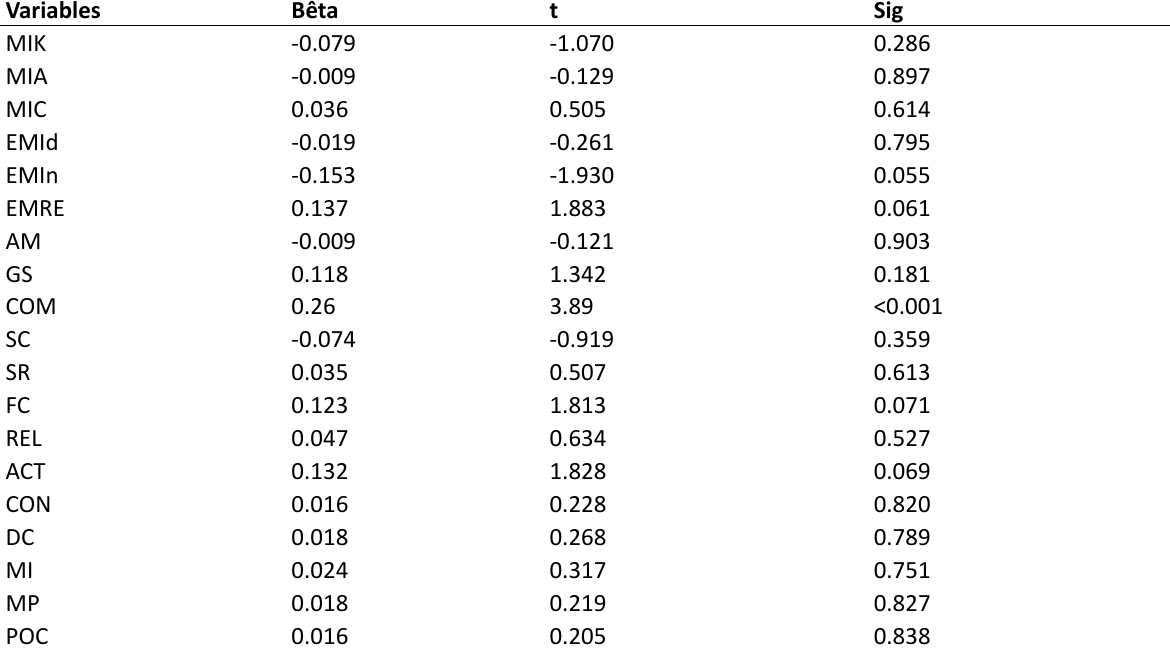
Table 3. Standardized coefficients of mental skills and forms of motivation and their Meanings